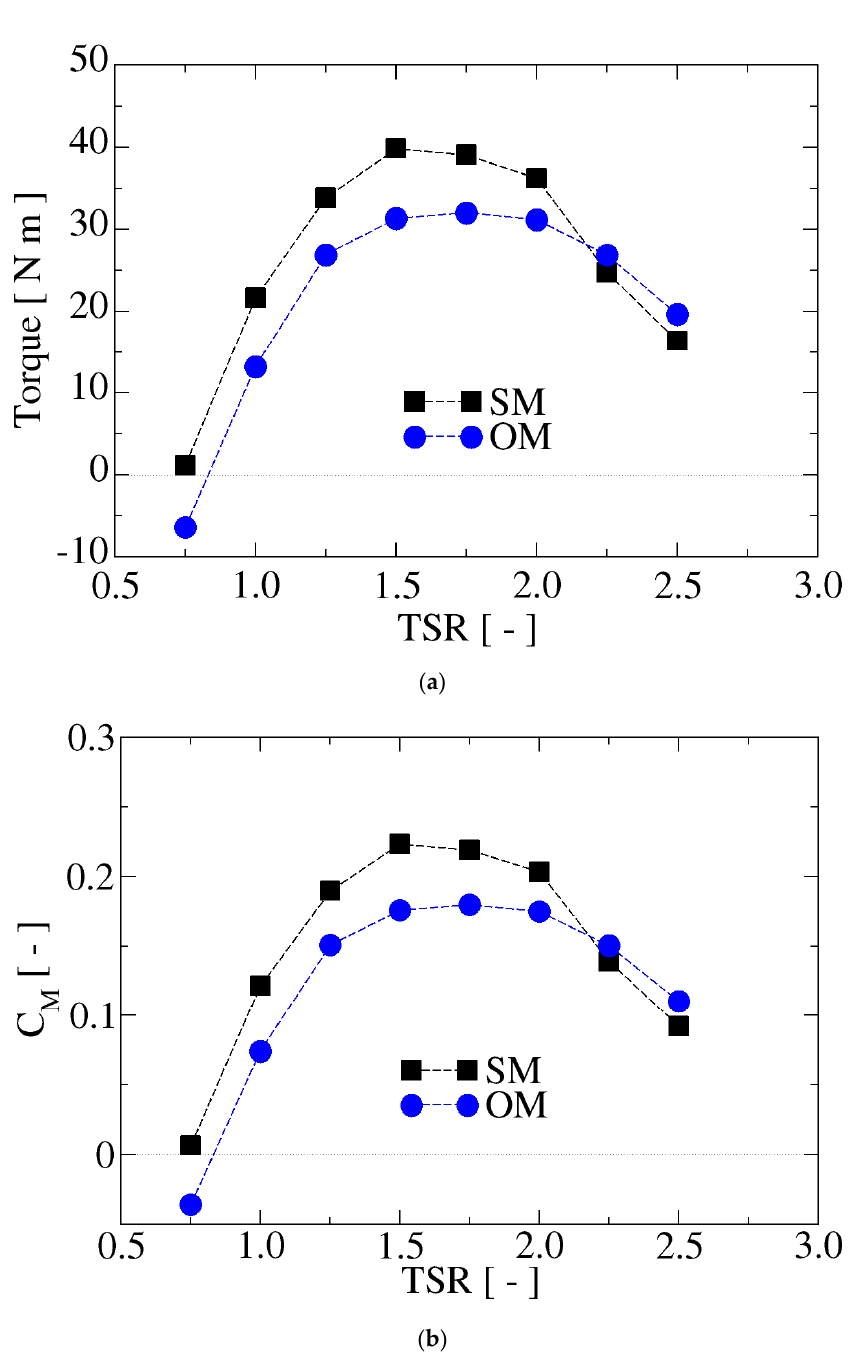
Figure 7. Turbine performance based on the generated torque ( a ) Nm, ( b ) 𝐶 (cid:3014) . A very interesting result was that both methods (SM and OM) agreed in the predic- tion of the peak performance of the turbine in which the peak 𝐶 (cid:3017) was achieved close to a TSR = 2 (see Figure 8). It was also observed that the curves predicted by both methods had very similar tendencies and shape. The maximum power coefficient predicted by both methods was close to 0.35, which is a value typically expected for small-size VATs. By performing a simple calculation, it was possible to estimate the highest power that the